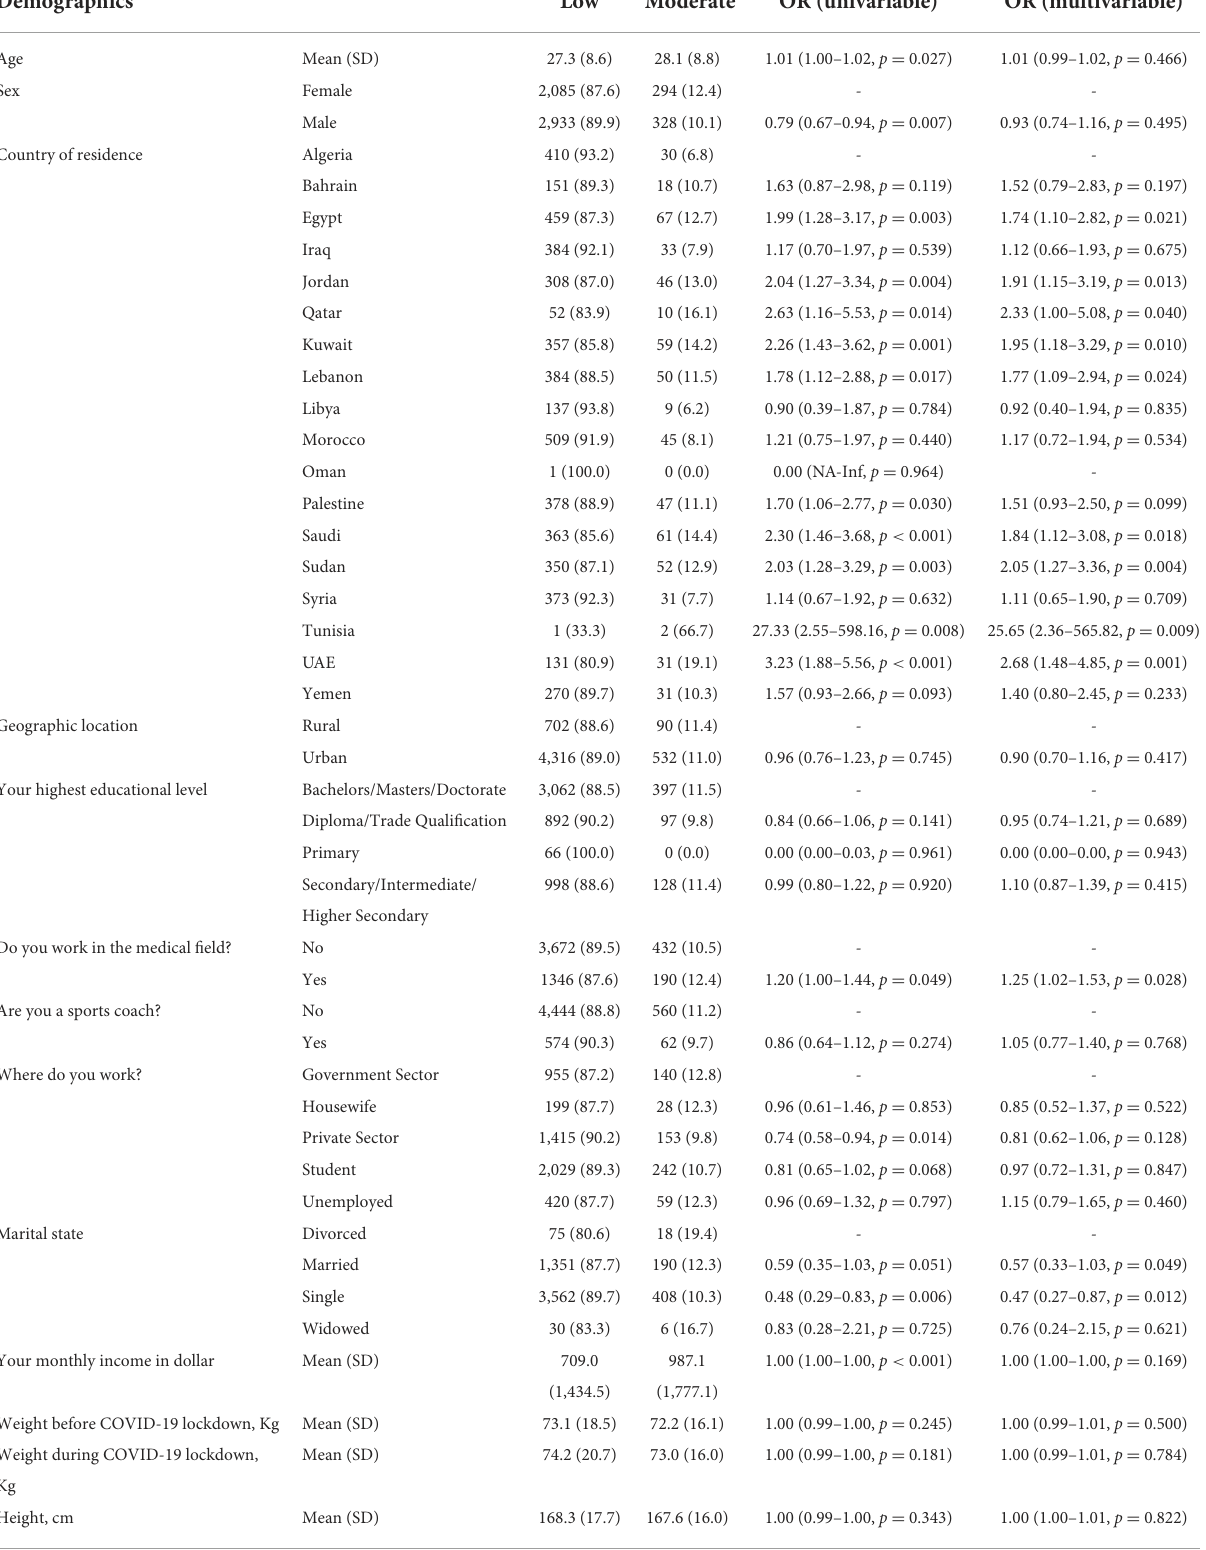
TABLE 8 Logistic regression models for the association between demographics and moderate level of